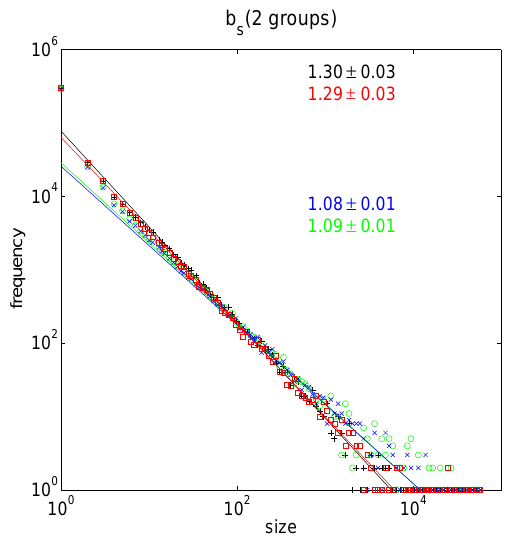
Figure 3. The log–log frequency–size display of four cases – the black and red cases are sparsely distributed and the blue and green cases are compactly grouped (Fig. 4a, and b). There are apparently two different groups for the scaling law: the black and red cases with the same sparse 10% coverage (although the heterogeneous threshold field is diversified for the black case but uniform for the red case; see the text) have similar values of the scaling exponent (approximately 1.30 ± 0.03), whereas the second group with com- pactly grouped heterogeneity irrespective of the diversity, location, and geometry (the blue and green cases in Fig. 4) all have similar b s values in the range of 1.08 ± 0.01 to 1.10 ±